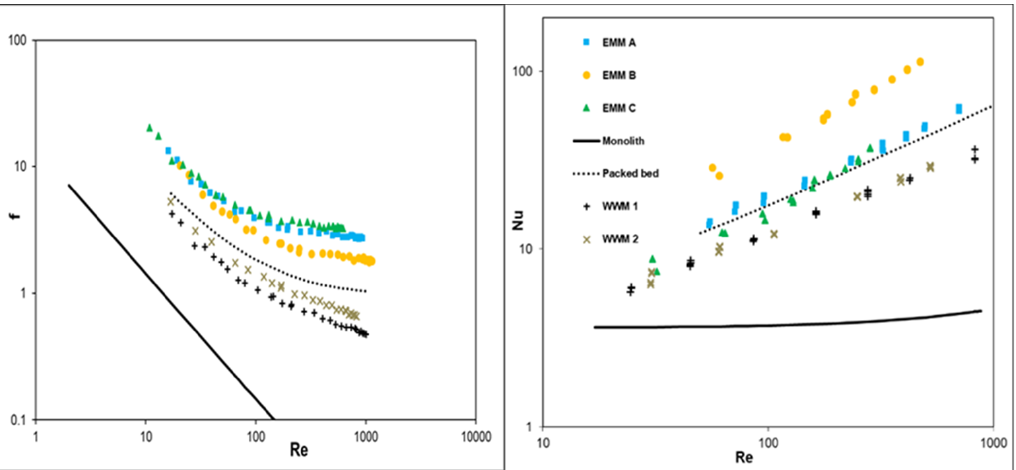
Figure 9. Comparison of flow resistance ( left ) and heat transfer ( right ) of different reactor packings. Table 5. Comparison of expanded meshes with other catalyst